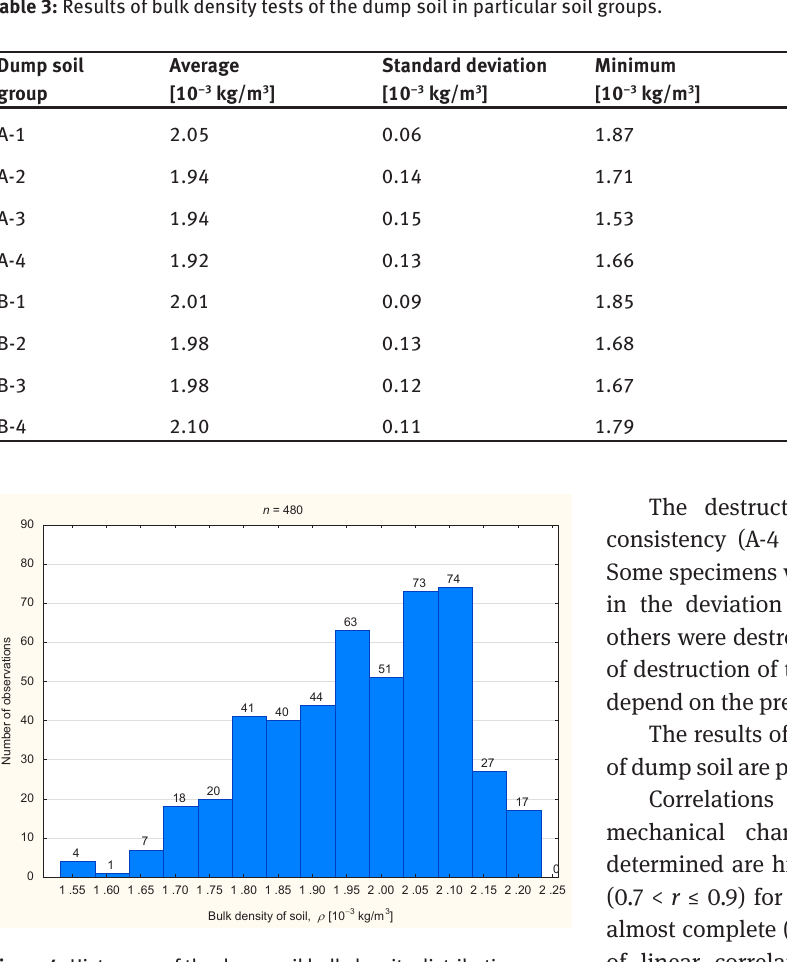
Figure 4: Histogram of the dump soil bulk density distribution.